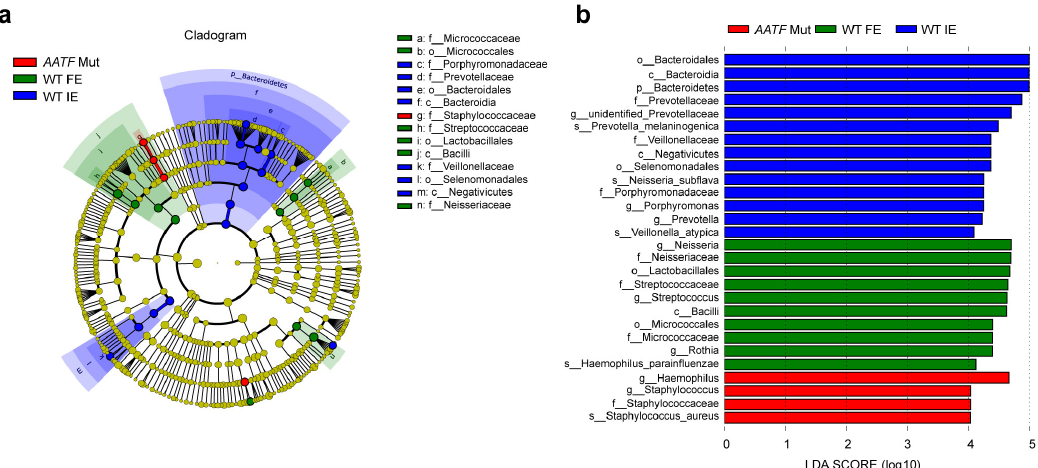
Figure 5. Linear discriminant analysis effect size (LEfSe) analysis revealed the discriminative mi- crobes. LEfSe cladogram ( a ) and histogram of linear discriminant analysis (LDA) score ( b ) show the biomarkers with significant differences groups, with LDA score > 4.0. The circle radiating from inside to outside represents the classification from the phylum to the genus. Each circle’s diameter represents the relative abundance and different species biomarker follows the group for coloring.